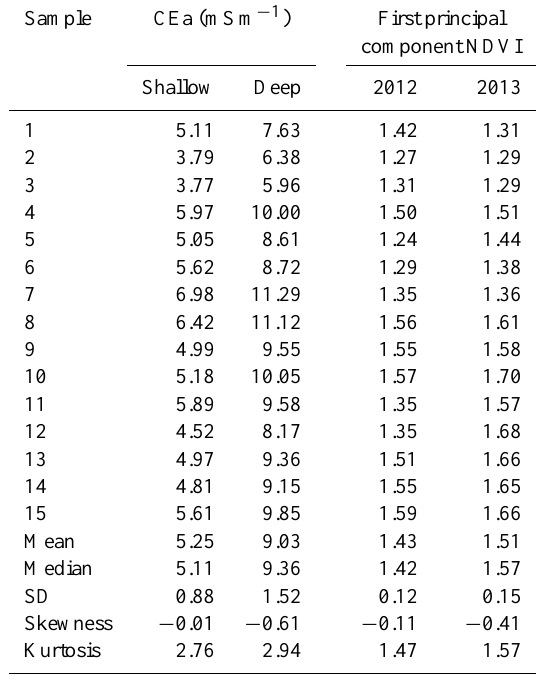
Table 3. CEa, shallow and deep, and first principal component of the NDVI at soil sample